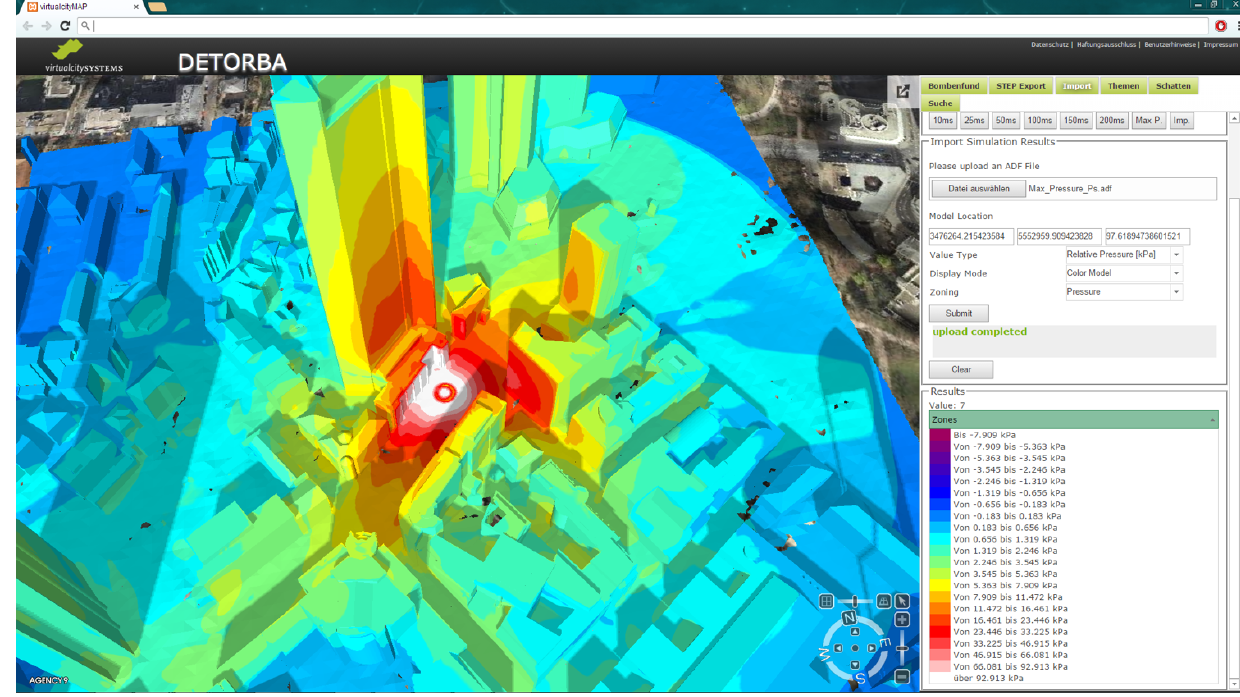
Figure 8. 3D city models may be used for simulation and analysis of the effects of explosions in urban areas. This example shows the blast pressure wave propagation in